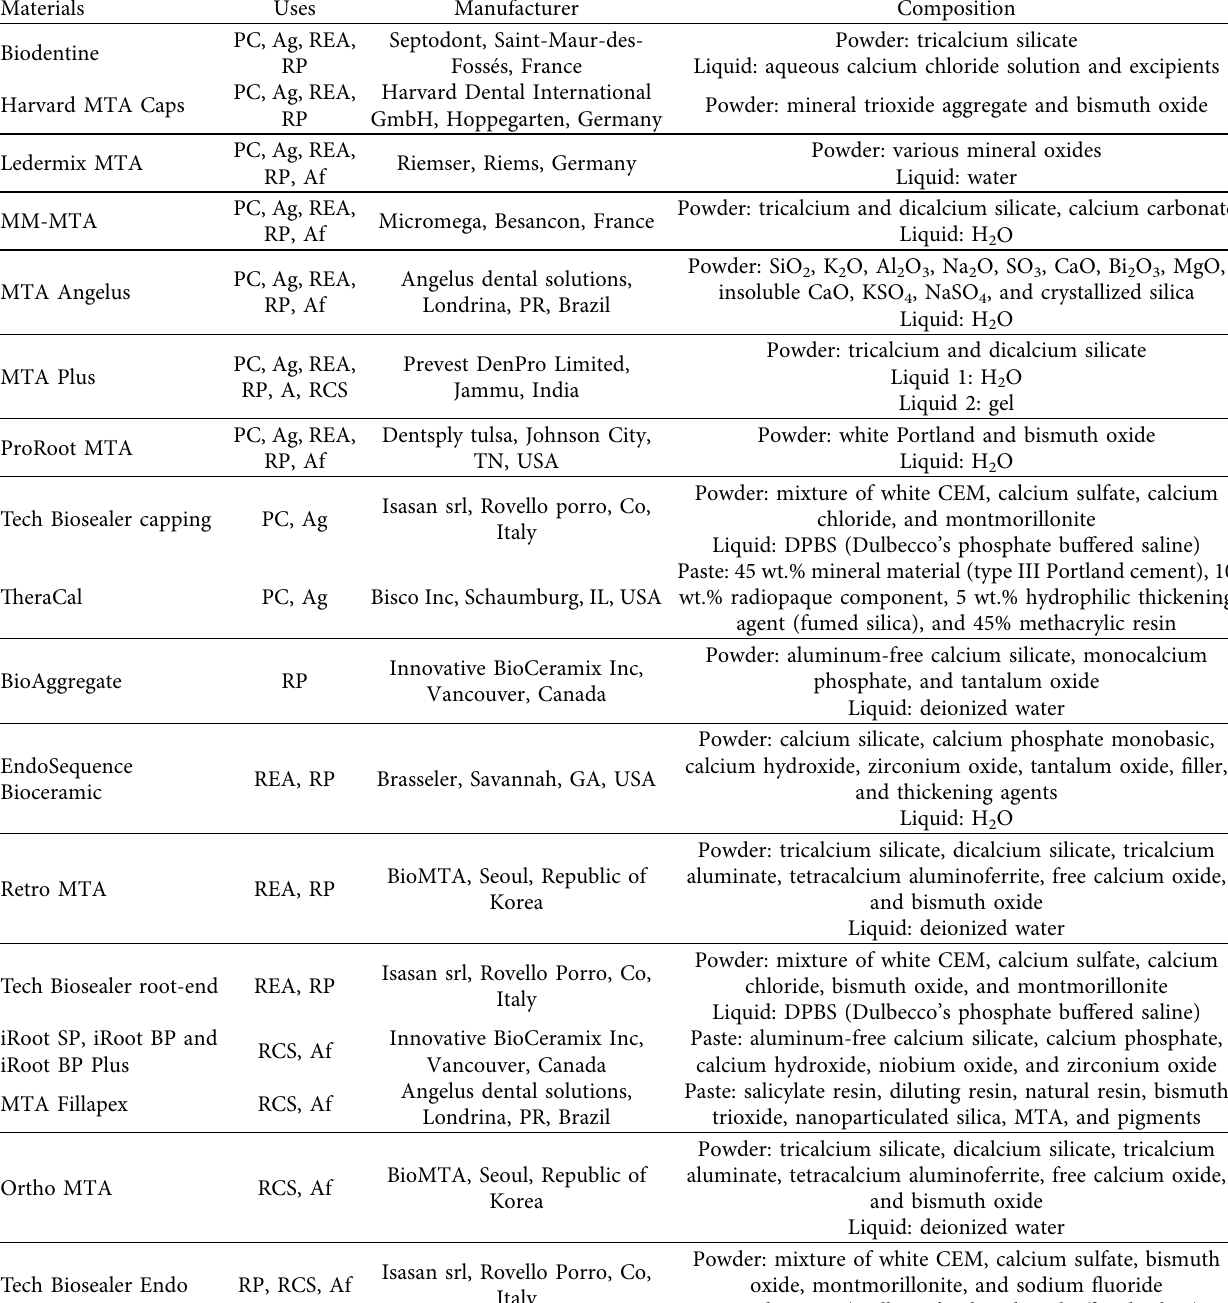
Table 2: Types of HCSCs and some calcium hydroxide materials for the endodontic process [13, 22–24]. Materials Uses Manufacturer